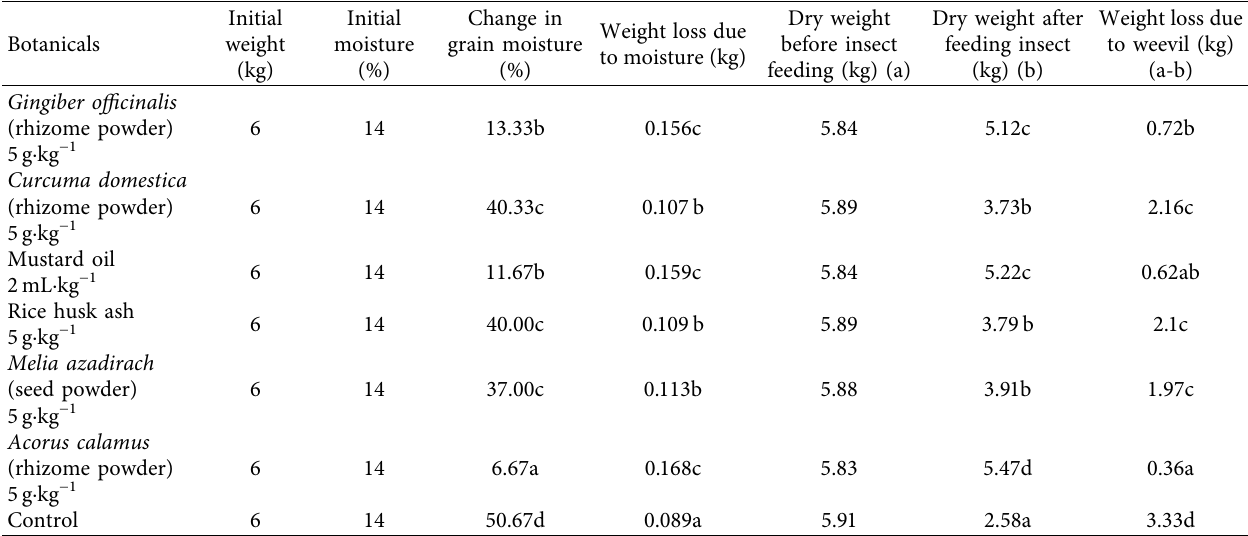
Table 4: Efects of diferent botanicals on weight loss by maize weevil ( Sitophilus zeamais Motsch.) after 120 days in maize seeds.